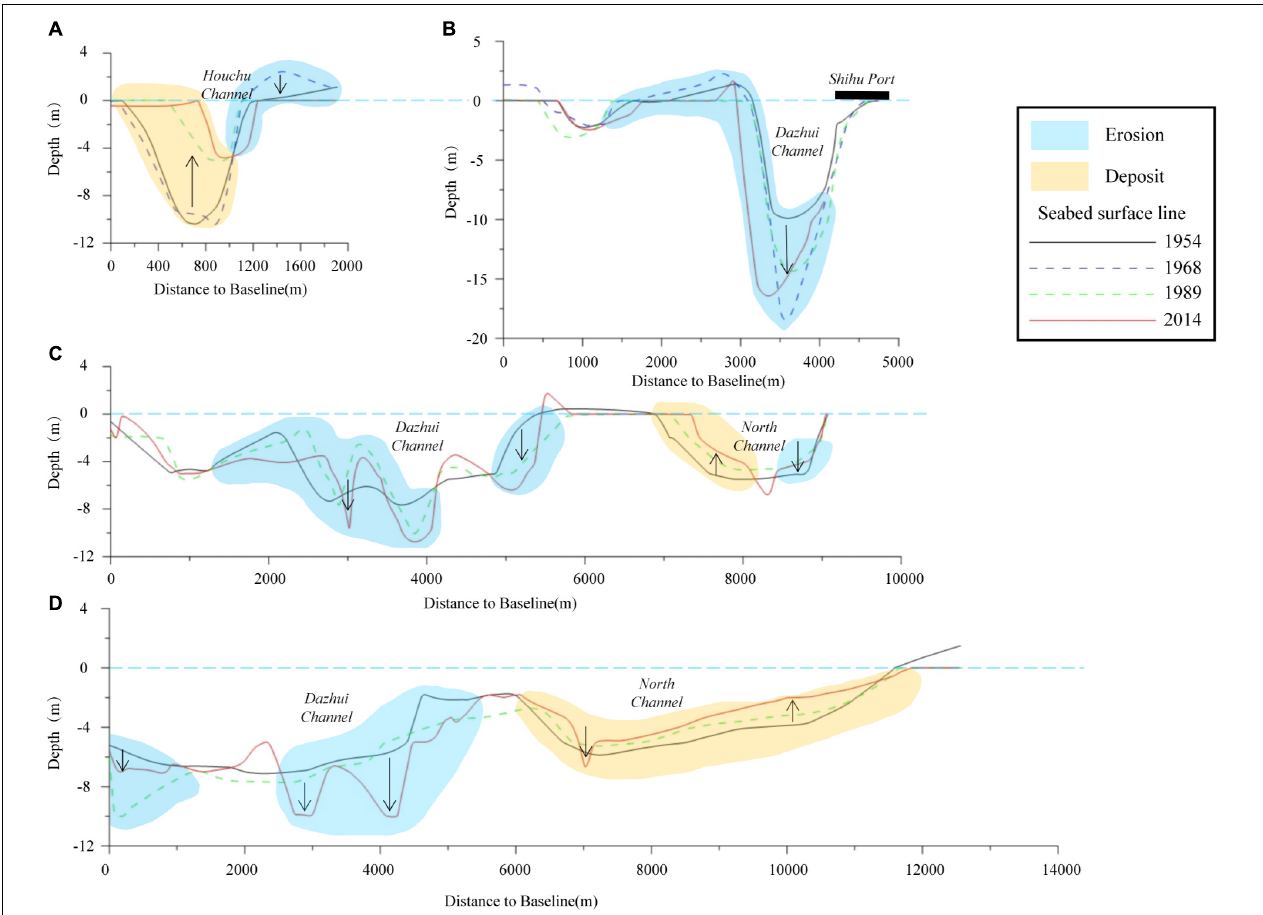
FIGURE 5 | Cross-shore topography variations along four profiles during the four different stages of industrialization from 1954 to 2017. The upward arrow indicates deposition, and the downward arrow indicates erosion. The elements in the section (A–D) are explained in part labels, where the blue areas represent erosional areas, the orange areas represent deposital areas, and different types of lines represent the seabed surfaces in the section for different